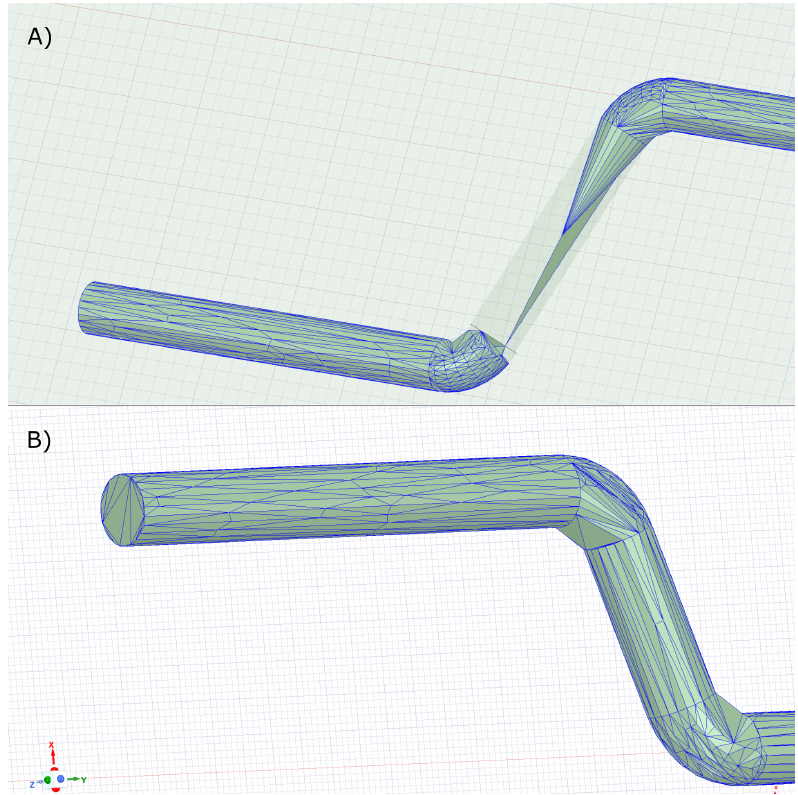
Figure 8. Examples of fibre meshes when ( A ) the default maximum mesh size was chosen and ( B ) when the maximum mesh size was limited to 0.26